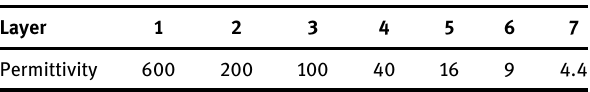
Table 1: Permittivity of different material layers in illusion device practical structure in Figure 5.